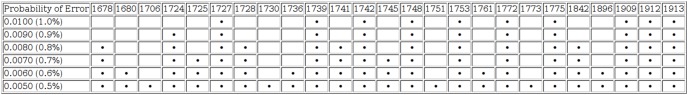
The second of two summary output tables provided by the “Deep Threshold Tool”.For each probability of error in the range specified (shown in reverse order in this table), a bullet is shown in the corresponding column of the table for each interesting column at which at least one mutation occurred at above-threshold frequency. This table can be consulted to determine the probability of error, which should be used on a given dataset. In this example, the well-characterized positions 1753, 1773 and 1896 are examined, and a probability of error of 0.005 selected, as this is the highest probability of error at which above-threshold mutations at the three positions are detected.